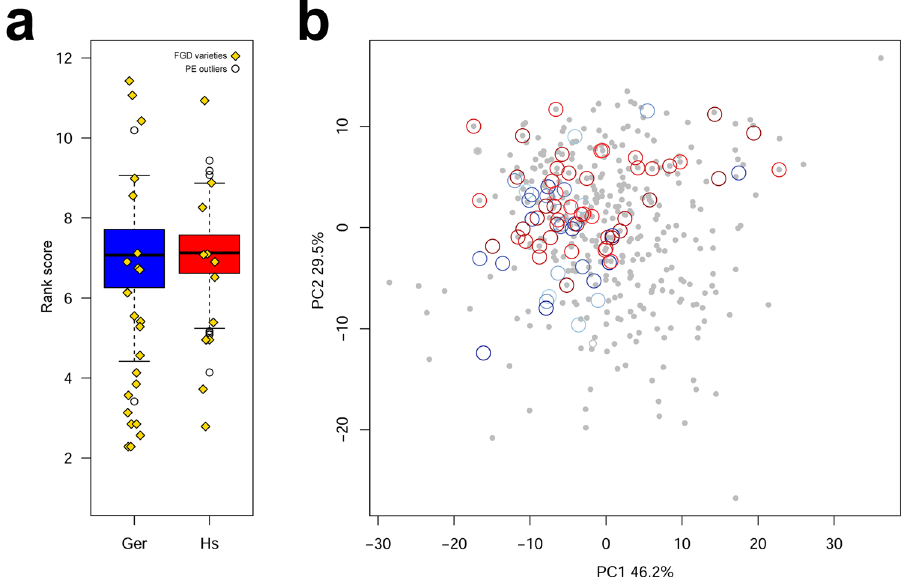
Figure 4. Ranking order of PE varieties. ( a ) Comparison between ranking score distributions in the two locations. Blue boxplot (Ger), Geregera; red boxplot (Hs), Hagreselam. Hollow circles outside upper and lower quartiles are outliers. Yellow diamonds are FGD varieties. ( b ) Top 50 PE wheat varieties in relation to phenotypic values. The panel depicts the first two PC axes extracted from metric measures of phenotypes averaged across the two locations. The top 50 varieties in Hagreselam and Geregera are represented by hollow circles in progressively darker red shades and blue shades, respectively. Twenty varieties were simultaneously selected in Hagreselam and in Geregera. Gray dots represent PE genotypes ranked 51 to 400. Preferred varieties in both locations are grouped in the top-left portion of the PC